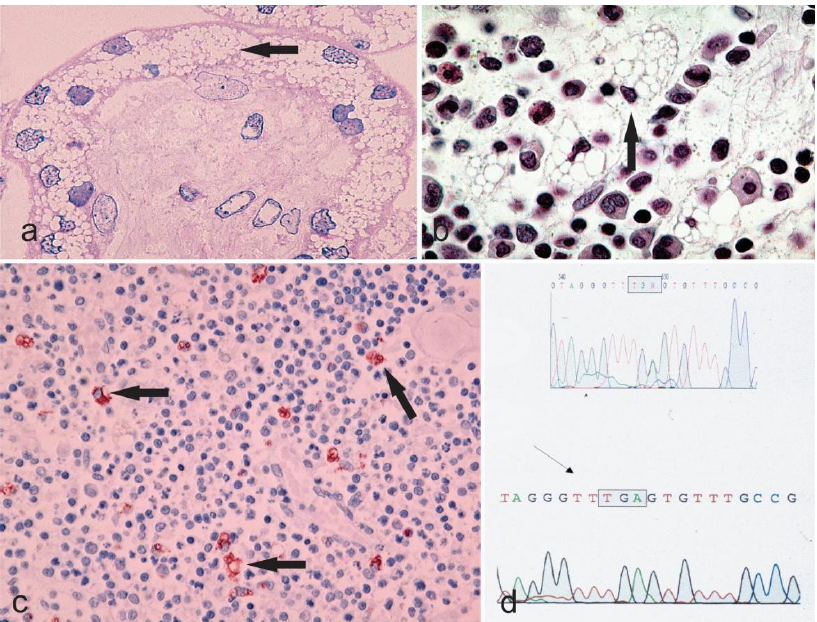
Figure 2. Microphotographs a – c showing the vacuolar degeneration of syncytium-trophoblast of a placenta (Hematoxylin & Eosin staining, 400×), bone marrow (Hematoxylin & Eosin staining, 630×, the arrow points to a cell with margination of the nucleus due to an engulfment of the cytoplasm with undigested material), and thymus (Anti-CD68 immunostaining, 200× with the arrows highlighting the macrophages) from a sialidosis pregnancy. The chromatogram in d shows the genetic alteration of the sialidosis gene.